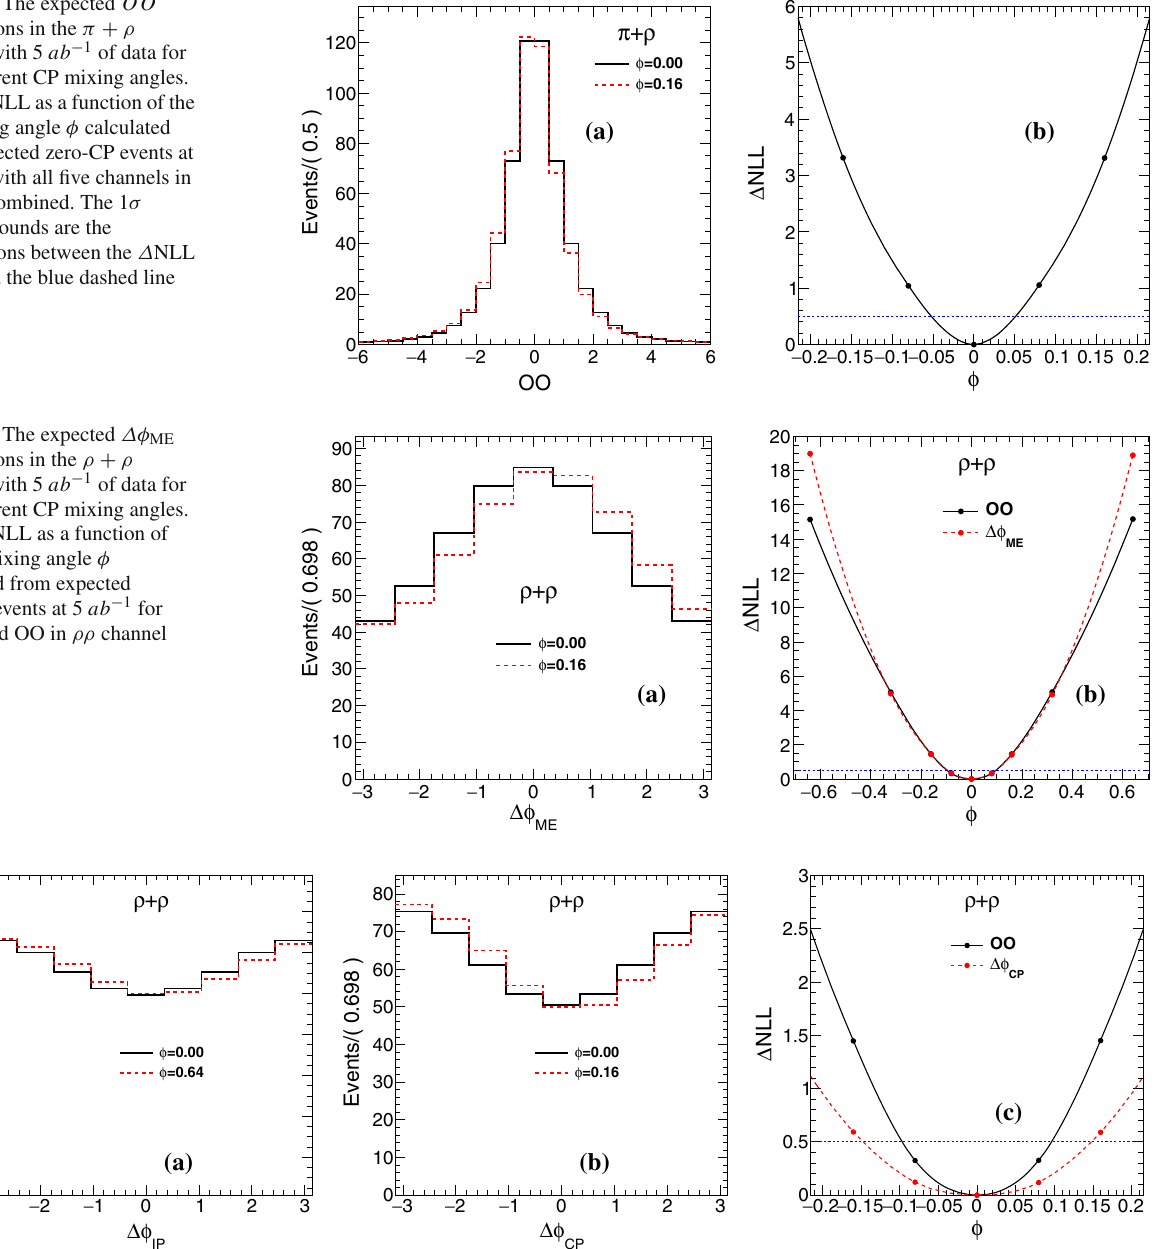
Fig. 8 The distributions of Δφ IP ( a ) and Δφ CP ( b ) in the ρ + ρ channel with 5 ab − 1 of data, using the impact parameter and Δφ CP method, respectively. The Δ NLL variations with the Δφ CP and the OO method are compared in ( c ) with the same